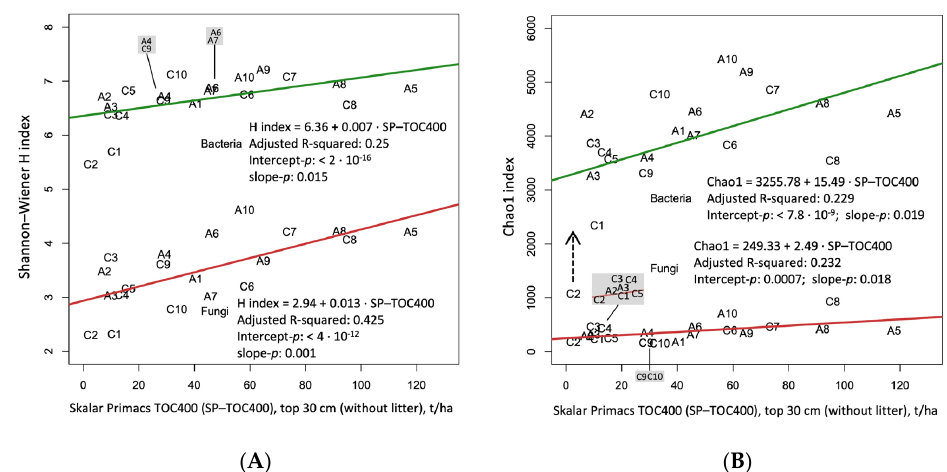
Figure 11. Linear regressions between ( A ) Shannon–Wiener or ( B ) Chao1 indices (OTUs of bacteria and fungi) and the Skalar Primacs TOC400 (SP–TOC400) in Albarella and Caleri. Let us remember that there is a strong linear model that links the measurements made with the Skalar Primacs (SP– TOC400) with those made with the Carbon Still (CS–TOC400) (Figure 10A) and (CS–TOCL400), also with the carbon contained in the litter, (Figure 10B).